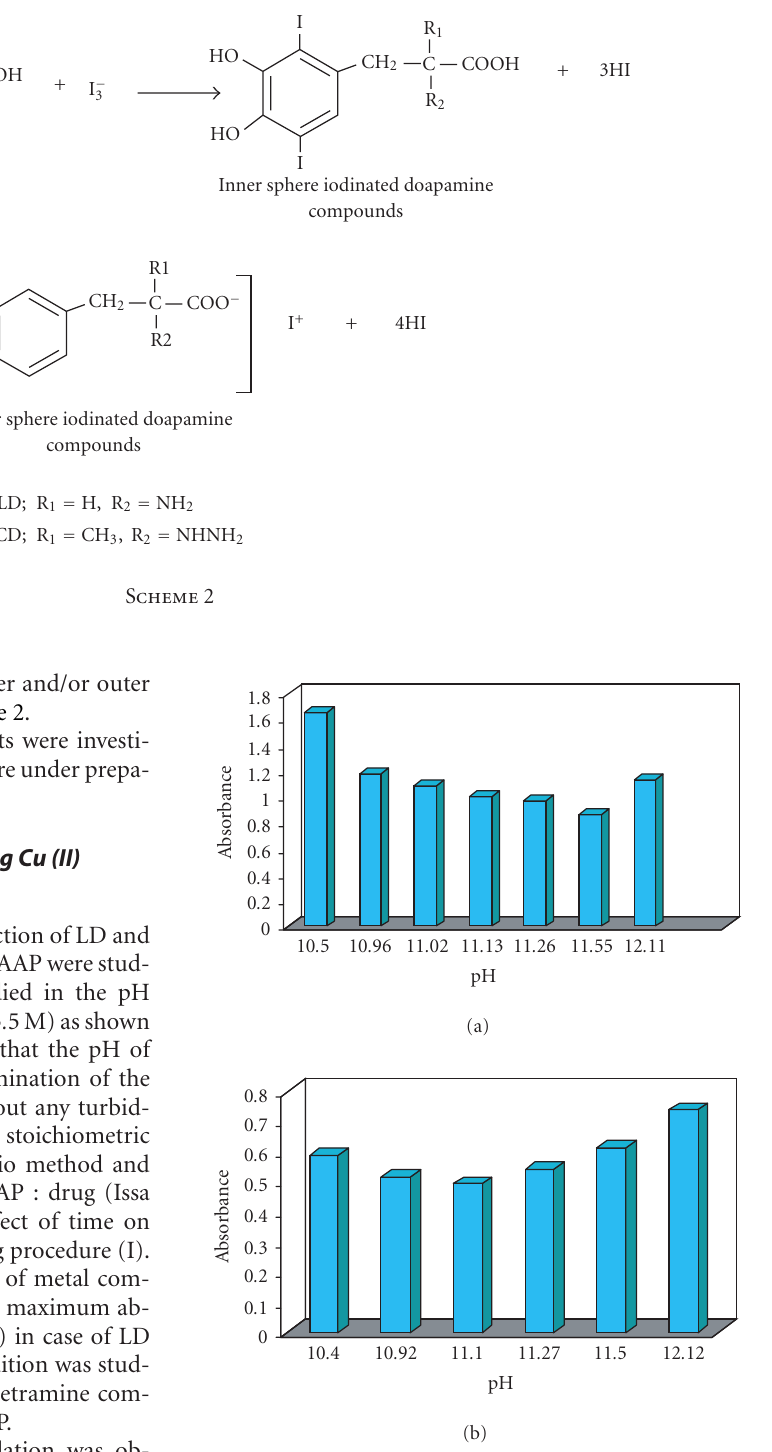
Figure 3. Clustered column showing relation between pH and absorbance in case of (a) LD-copper (II) complex and (b) CD- copper (II) complex. 1 . 7 × 10 3 L mol − 1 cm − 1 , whereas Sandell sensitivities are 0 . 014 and 0 . 019 g cm − 2 for LD and CD, respectively. The correlation coe ffi cient was found to be 0 . 999 and 0 .